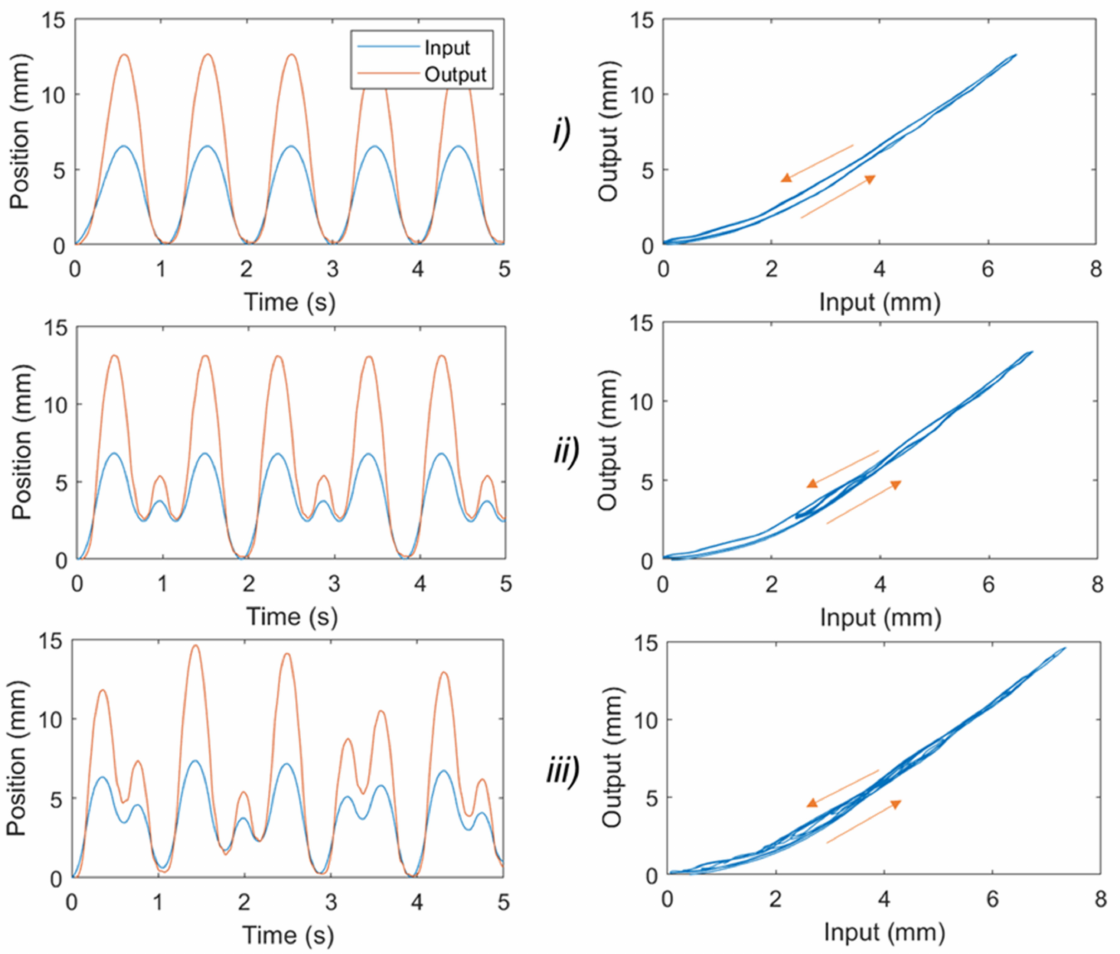
Figure 4. Experimental results for the soft actuator (SA2). Different input signals applied to the syringe plunger. They include 1 Hz sine wave input ( i ); two pairings of sine waves (combined frequency of 1 Hz and 1.5 Hz, ( ii )); and two pairings of sine waves (combined frequencies of 1 Hz and 1.73 Hz, ( iii )). ( Left panel ) Time history of the input and output displacement. ( Right panel ) input displacement of the syringe plunger versus the SA2